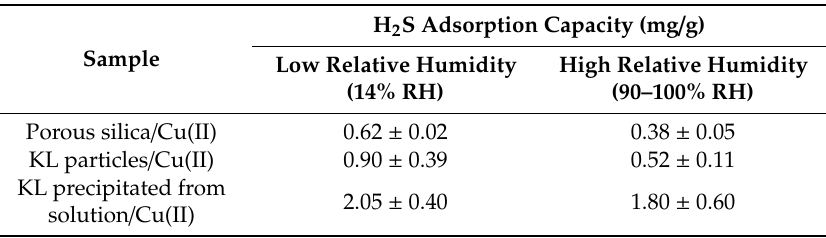
Table 1. H 2 S adsorption capacities in milligrams per gram of adsorbent material for copper-adsorbed silica, copper-adsorbed kraft lignin particles, and copper-adsorbed kraft lignin obtained via precipitation from a solution, which was tested at low and high relative